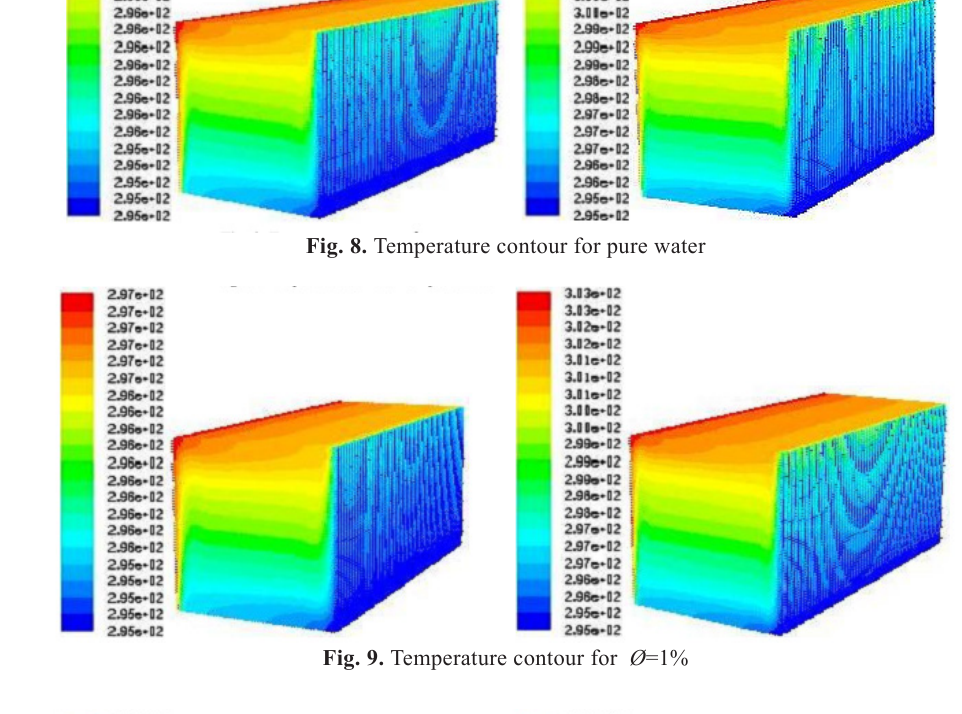
Fig. 9. Temperature contour for Ø =1%